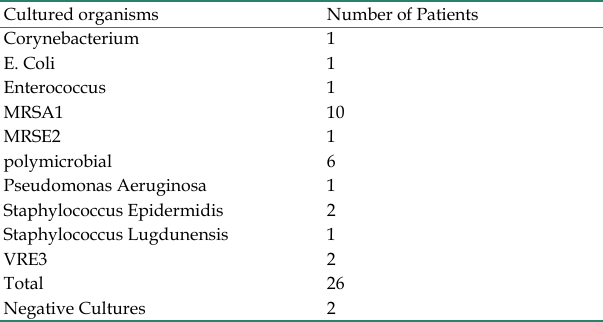
Table 2. Results of intraoperative cultures Cultured organisms